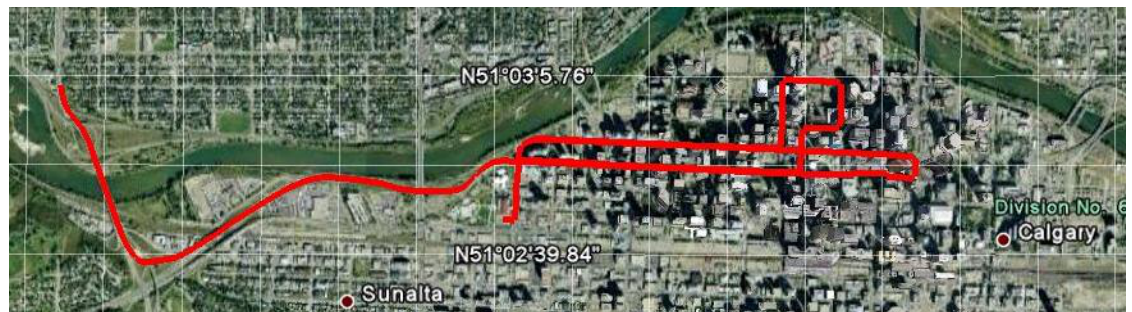
Figure 5. Test trajectory (from Google Earth).